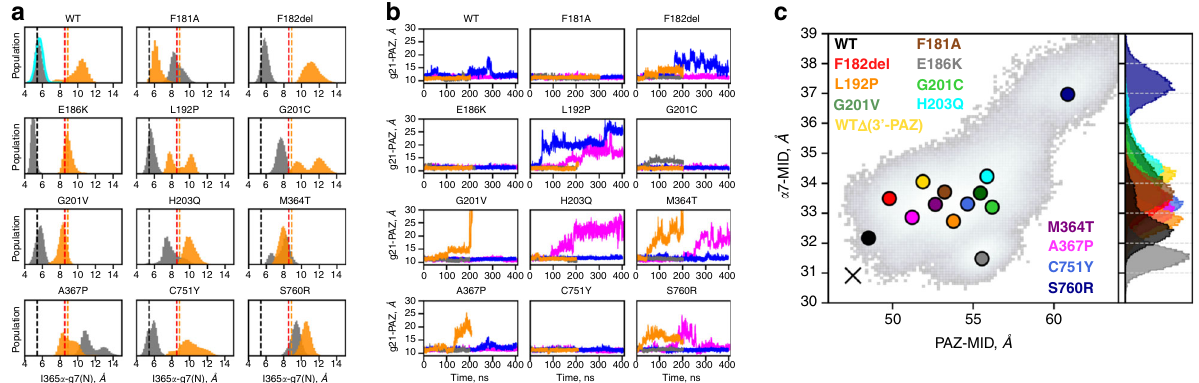
Fig. 4 Molecular dynamic simulation of effects of AGO2 mutations. a Distance between the C α atom of I365 and the glycosidic N atom of the g7 residue of the guide (I365 α -g7(N)). Populations of all core-RISC trajectories were normalized to the same bin number (60). Black and orange dashed vertical lines denote the reference X-ray structures of the int and nonint core-RISC states (4OLA and 4W5N, respectively). The red dashed line denotes the X-ray structure of the helix-7 mutant (5WEA). b Distance between the c.o.m. of the 3 ′ -end of the guide and the c.o.m. of the PAZ domain (g21-PAZ) along the trajectories of all RNA-bound states. Note that the relatively short length of the individual MD trajectories could affect the results. Color code of the states in both a and b panels: apo-Ago2 — green, int core-RISC — gray, nonint core-RISC — orange, g2-8 holo-RISC — magenta and g2-7 holo-RISC — blue. c d motion of the helix7 and the PAZ domain along the open-closed mode (left panel, gray scale histogram). The histograms are calculated by concatenating the last 100 ns of non-biased trajectory of each variant with mismatched RNA duplex. Colored circles depict the maximum population density of each trajectory. Black cross denotes the maximum population density of the WT AGO2 with guide RNA. Right panel: population histograms on α 7-MID corresponding to the maxima on the left panel. Equivalent analysis of the variants in in complex with a fully matched seed duplex is shown on Fig. holo RISC) or with a mismatch at position 8 of the guide (v; g2-8,